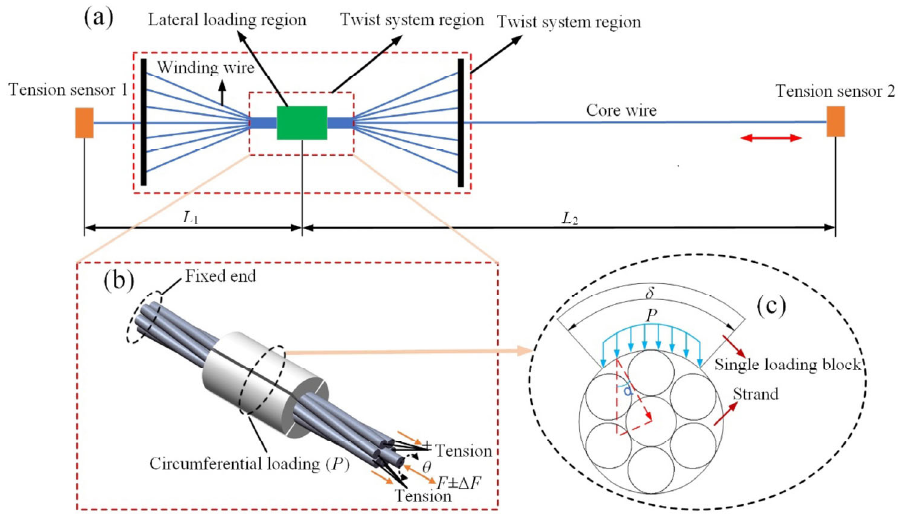
Fig. 4 Test schematic diagram. (a) Overall structure drawing, (b) force diagram of rope strands, and (c) force diagram of section of rope strand. Note: L 1 is the distance from tension sensor 1 to the wear section, L 2 is the distance from tension sensor 2 (tensile end) to the wear section, δ is the span angle of the load block, and α is the intersection angle between the applied load and the contact